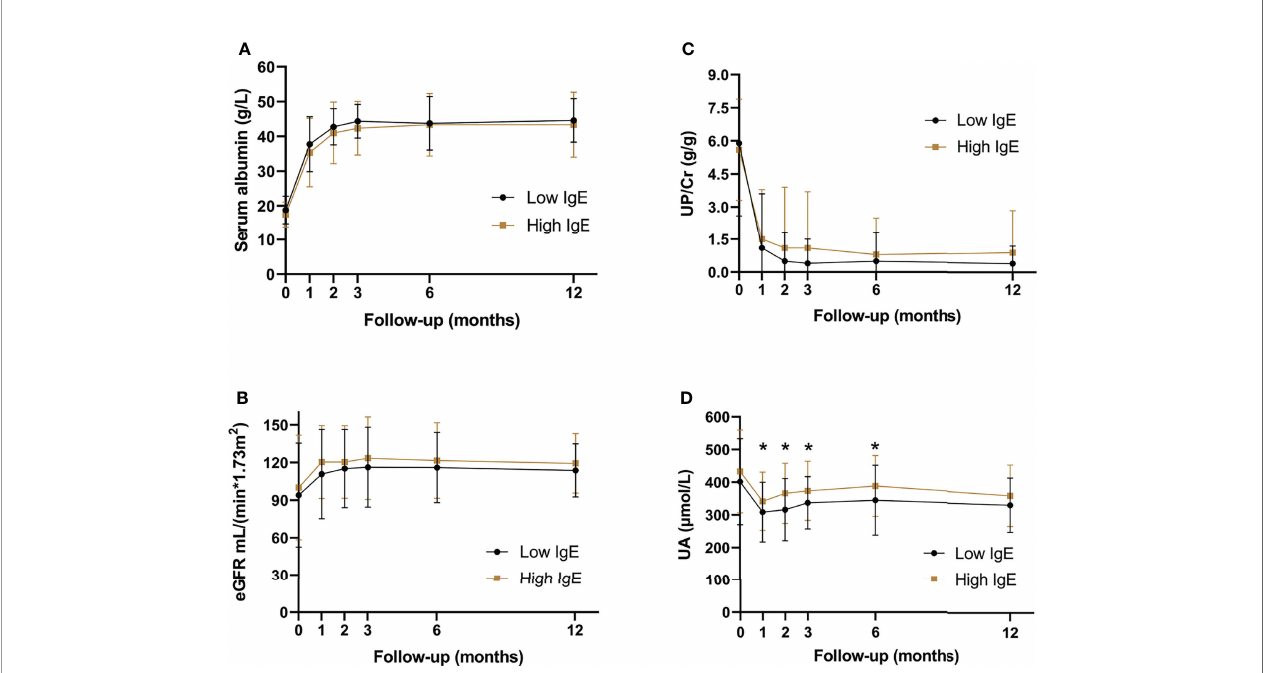
FIGURE 4 | Serum biochemical indexes of patients with minimal change disease during follow-up period. (A) serum albumin levels, (B) estimated glomerular fi ltration rate, (C) urine protein-creatinine ratio, and (D) serum uric acid levels. * P < 0.05, signi fi cant difference between the high- and low-IgE